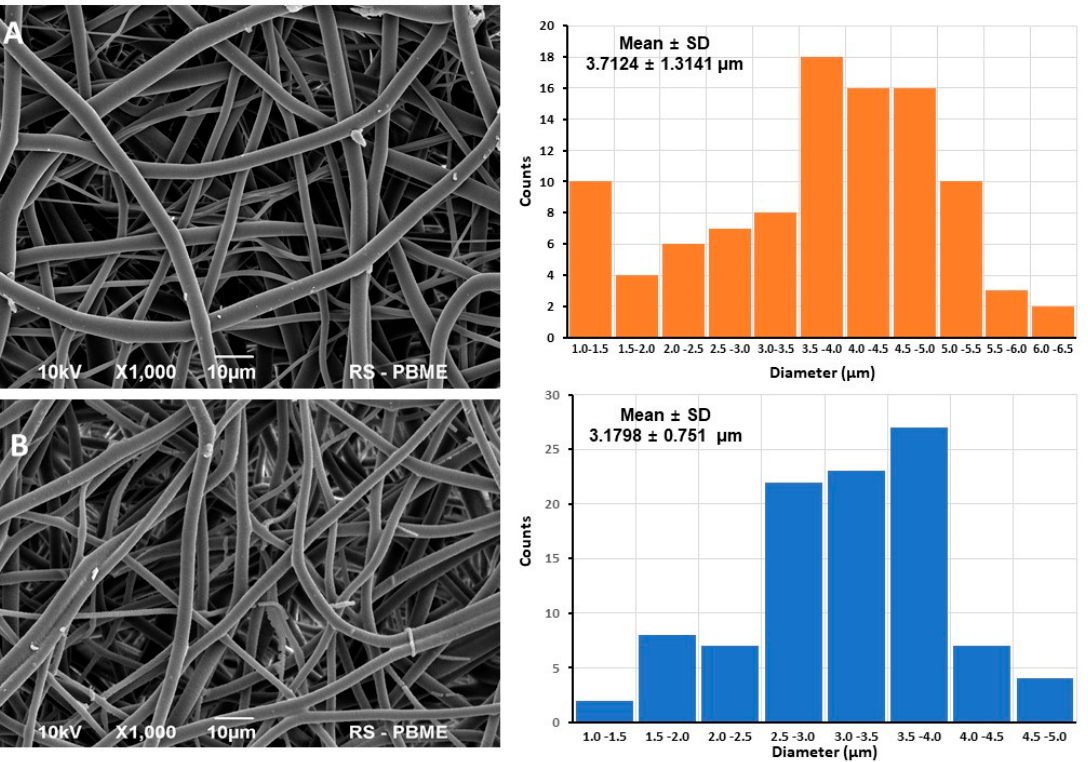
Figure 1. Scanning electron microscopy images of ( A ) PLCL before and ( B ) after modification and the corresponding nanofiber diameter distribution determined by measuring 100 fibers from SEM images. Scale bar = 10 μ m.